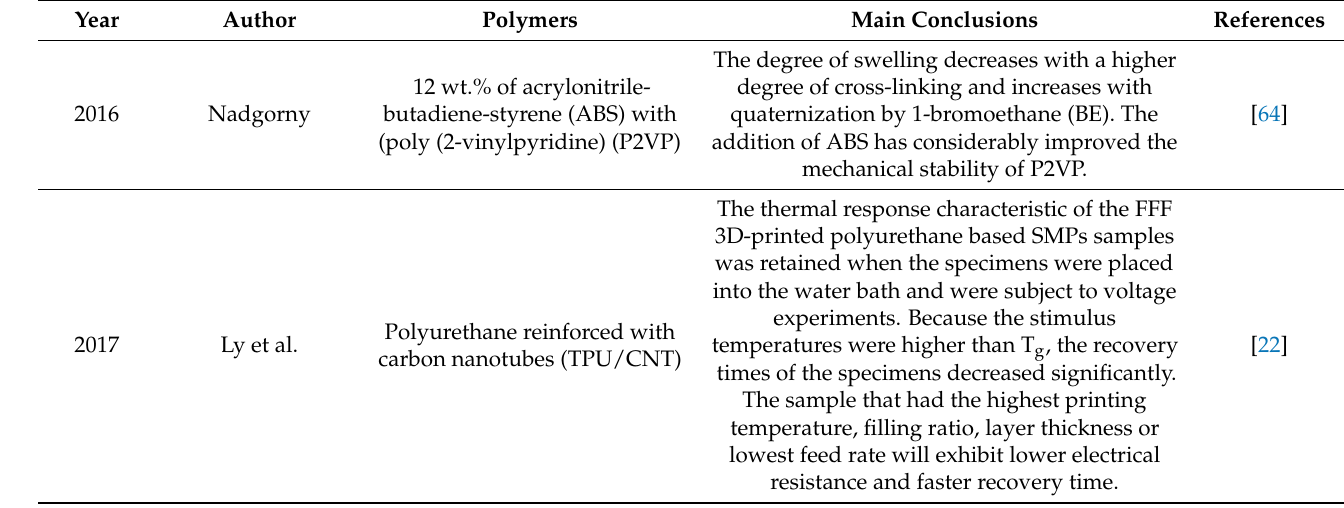
Table 2. Articles published on shape memory composites printed via